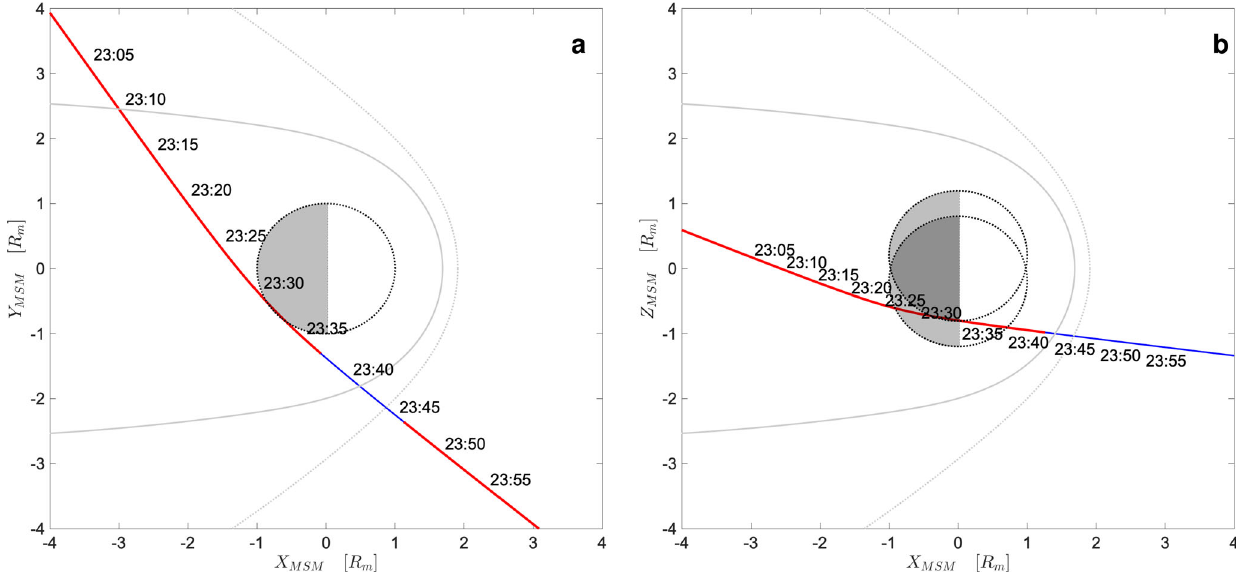
Fig. 1 | Trajectory ofBepiColombo during MFB1. The trajectoryof BepiColombo duringtheintervalof interest, a intheX MSM -Y MSM plane, b intheX MSM -Z MSM plane. Thesolidgraylinerepresentsthemagnetopausesurface,whilethedashedgrayline